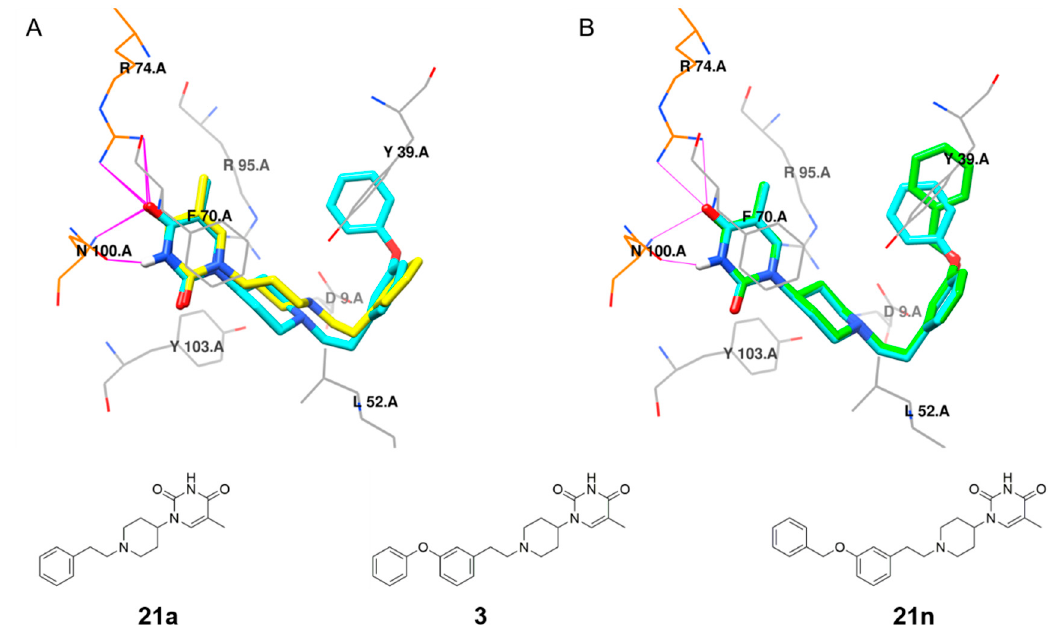
Figure 3. ( A ) Structure overlay of compound 3 (cyan) and 21a (yellow) docked in the Mtb TMPK (PDB 5NR7) [14] active site. ( B ) Structure overlay of compound 3 (cyan) and 21n (green) docked in the